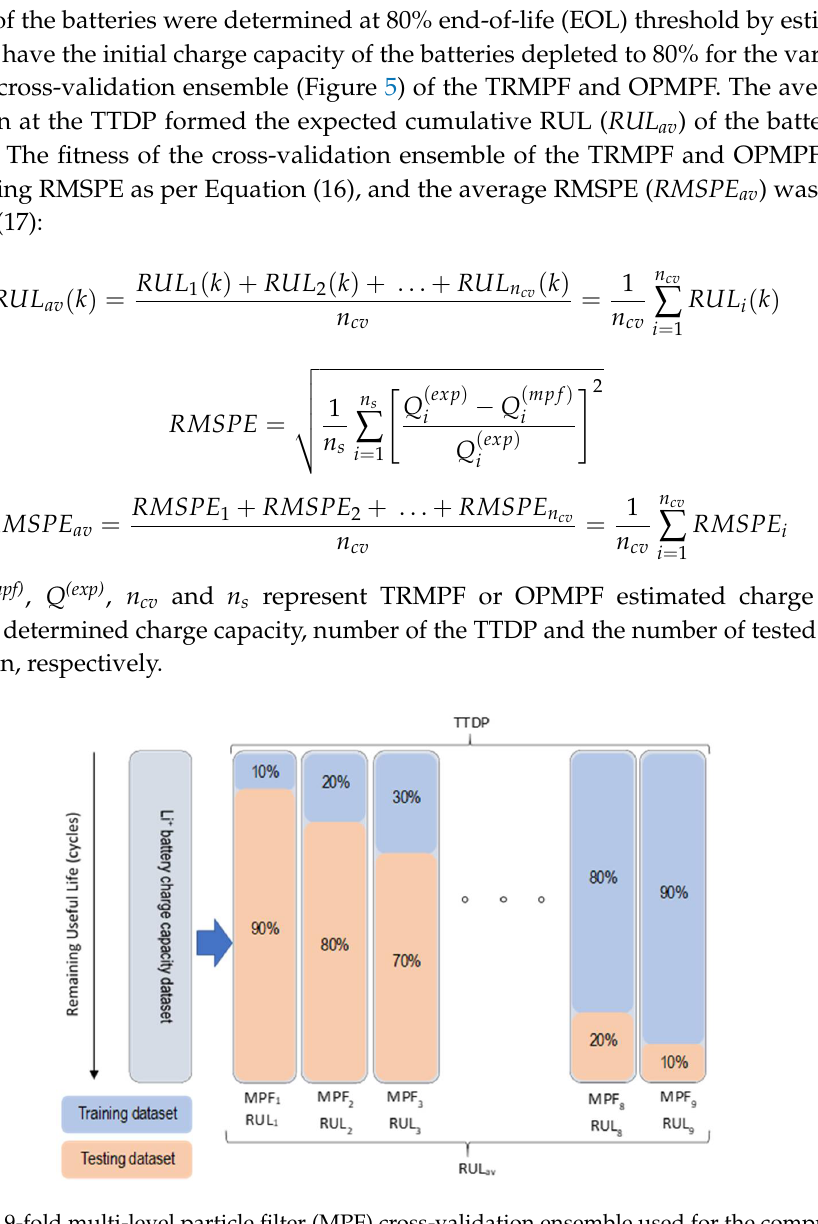
Table 1. Summary of the difference between the GA estimated charge capacities and the experimental results as determined with the mean absolute error (MAE) and mean absolute percentage error (MAPE) at the 80:20 TTDP.